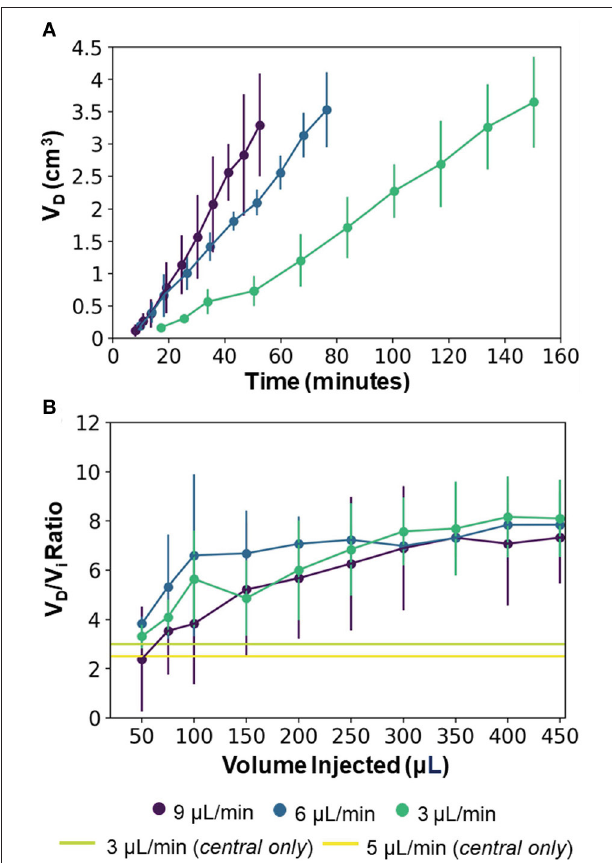
FIGURE 6 | (A) Average volume distribution over time and (B) average distribution ratio with the MINT devices at varying flow rates. The green and yellow horizontal lines provide a reference to the single-needle CED from the central microcannula at 3 and 5 µ L/min, respectively (data from Supplementary Figure 3 ) and represent the final V D /V i at V i = 450 µ L. Error bars represent ± S.D. from n = 3